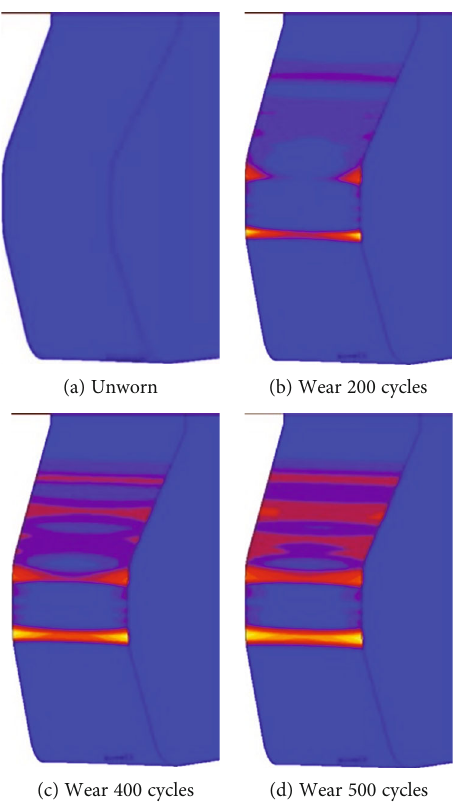
Figure 20: Wear map of 001 fi nger lock in di ff erent steps.